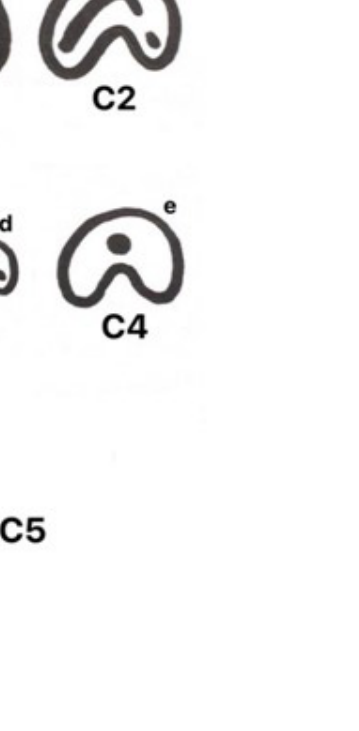
Fig. 3 - Measurement of angles for the C3 canal. Both angle α and angle ꞵ are less than 60 ° . (A and B) - ends of one canal cross - sec�on; (C and D) - ends of another canal cross - sec�on; M - middle point of line AD; α - angle between line AM and line BM; ꞵ - angle between line CM and line DM [35]. Diagrams drawn according to the paper by Fan et al.